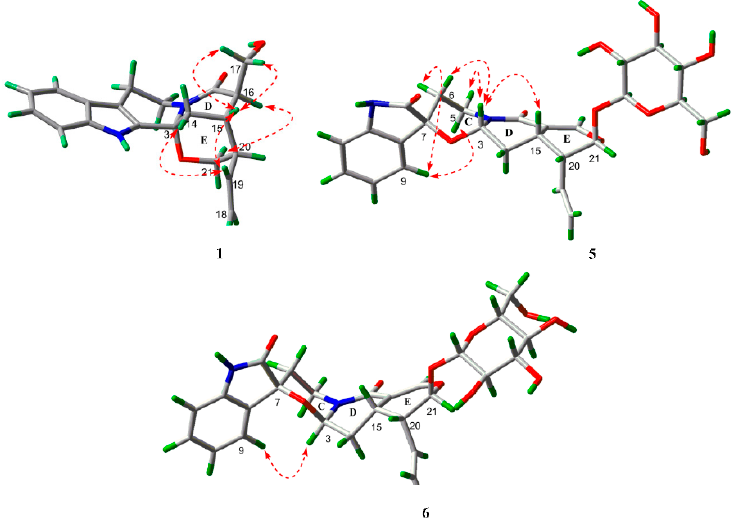
Figure 3. Selected ROESY correlations of 1 , 5 and 6 .